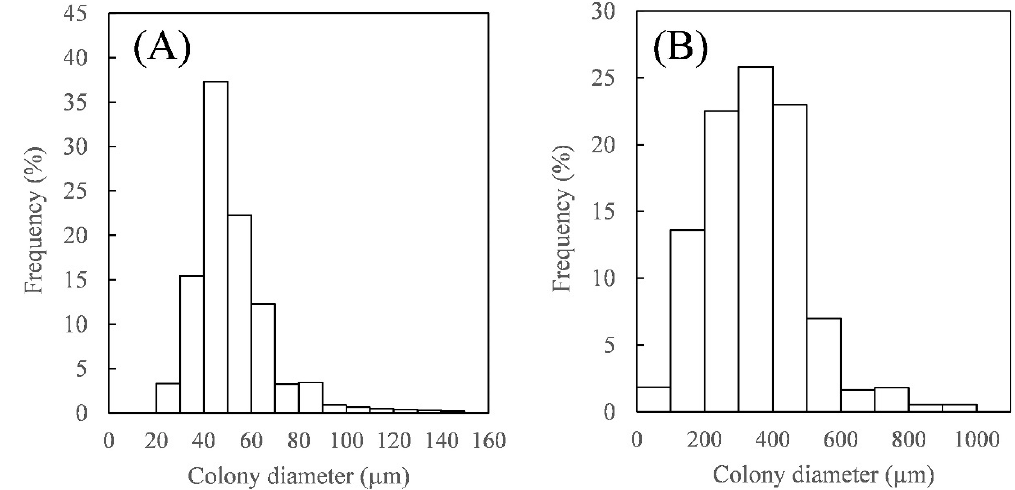
Figure 3. Size distributions of algal colonies cultured in ( A ) the freshwater medium and ( B ) the brackish water medium.